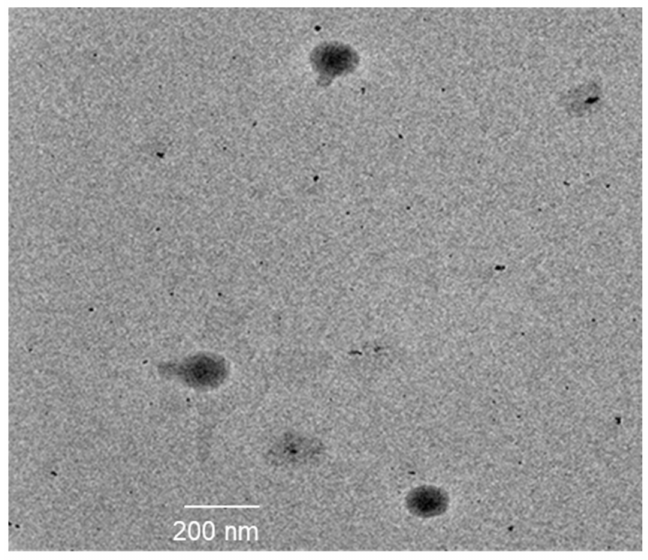
Figure 2. TEM image of